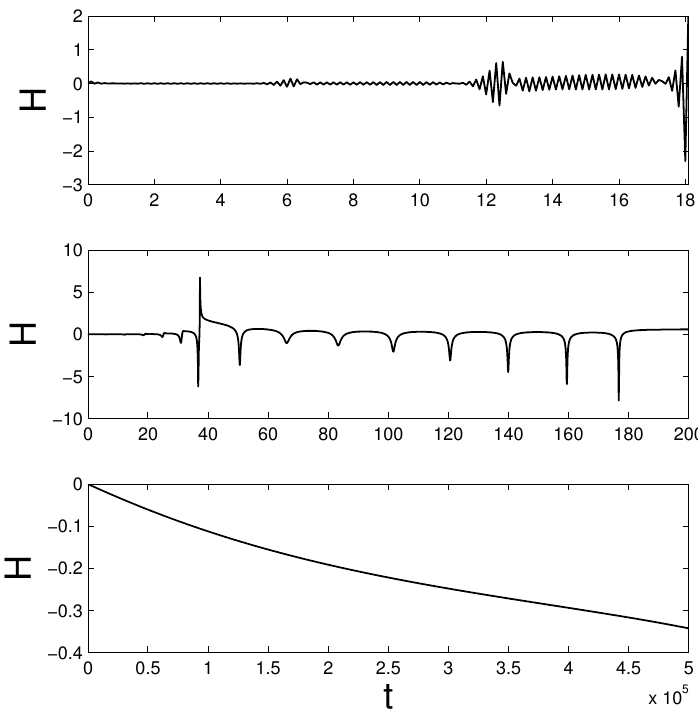
Figure 4. Hamiltonian for the numerical solution of Kepler’s problem obtained with the 3- and 4-stage Lobatto IIIA-IIIB schemes ( top , middle ), respectively, and the non-variational Radau IIA method ( bottom ).